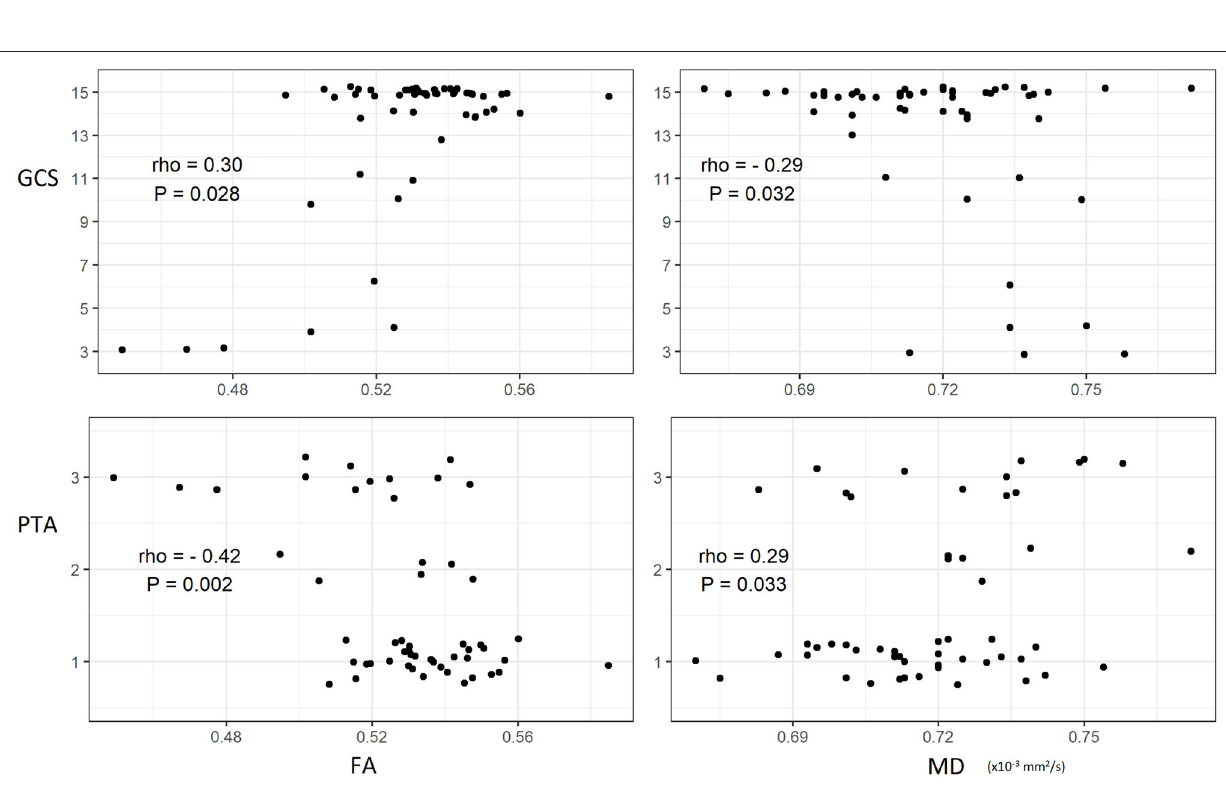
Frontiers in Neurology |